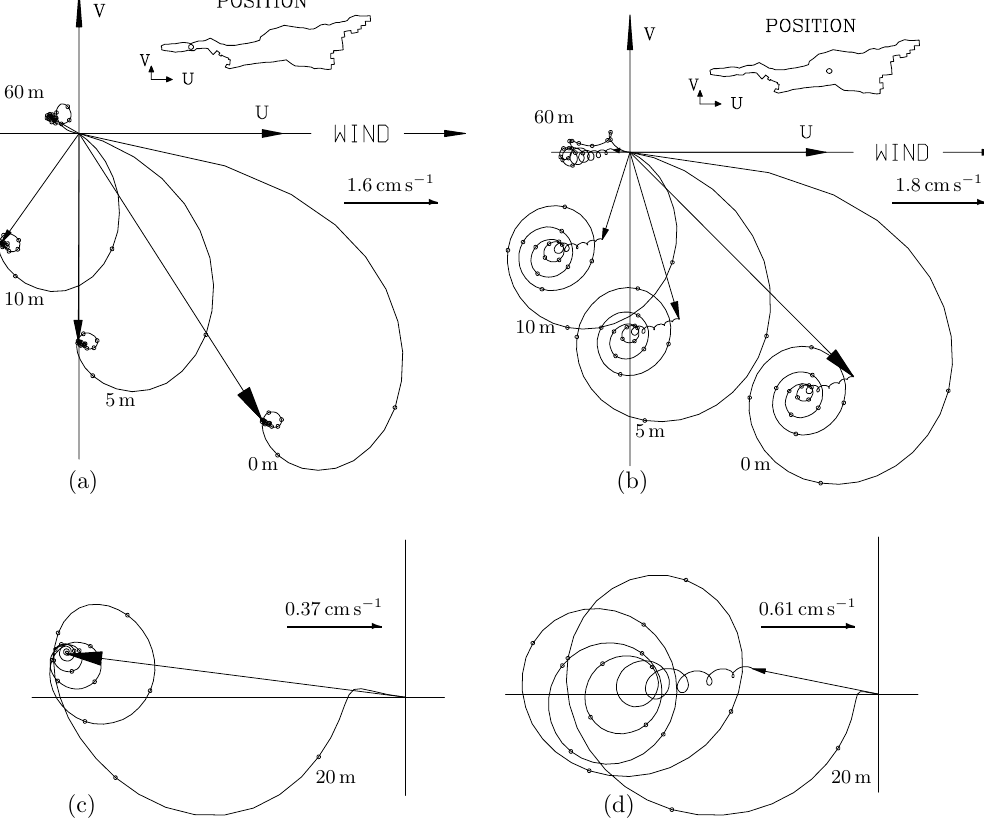
FIG. 13: Hodographs, i.e., time series of the horizontal velocities in the middles of the ¨Uberlinger See (a) and the Obersee (b) in 0, 5, 10 and 60 m depths. The motion is set up from rest. The small circles mark time intervals of approximately four hours. In order not to confuse the spirals at 20 m and 60 m depths, the 20 m hodographs are shown separately in the panels (c) and (d) for the two positions.